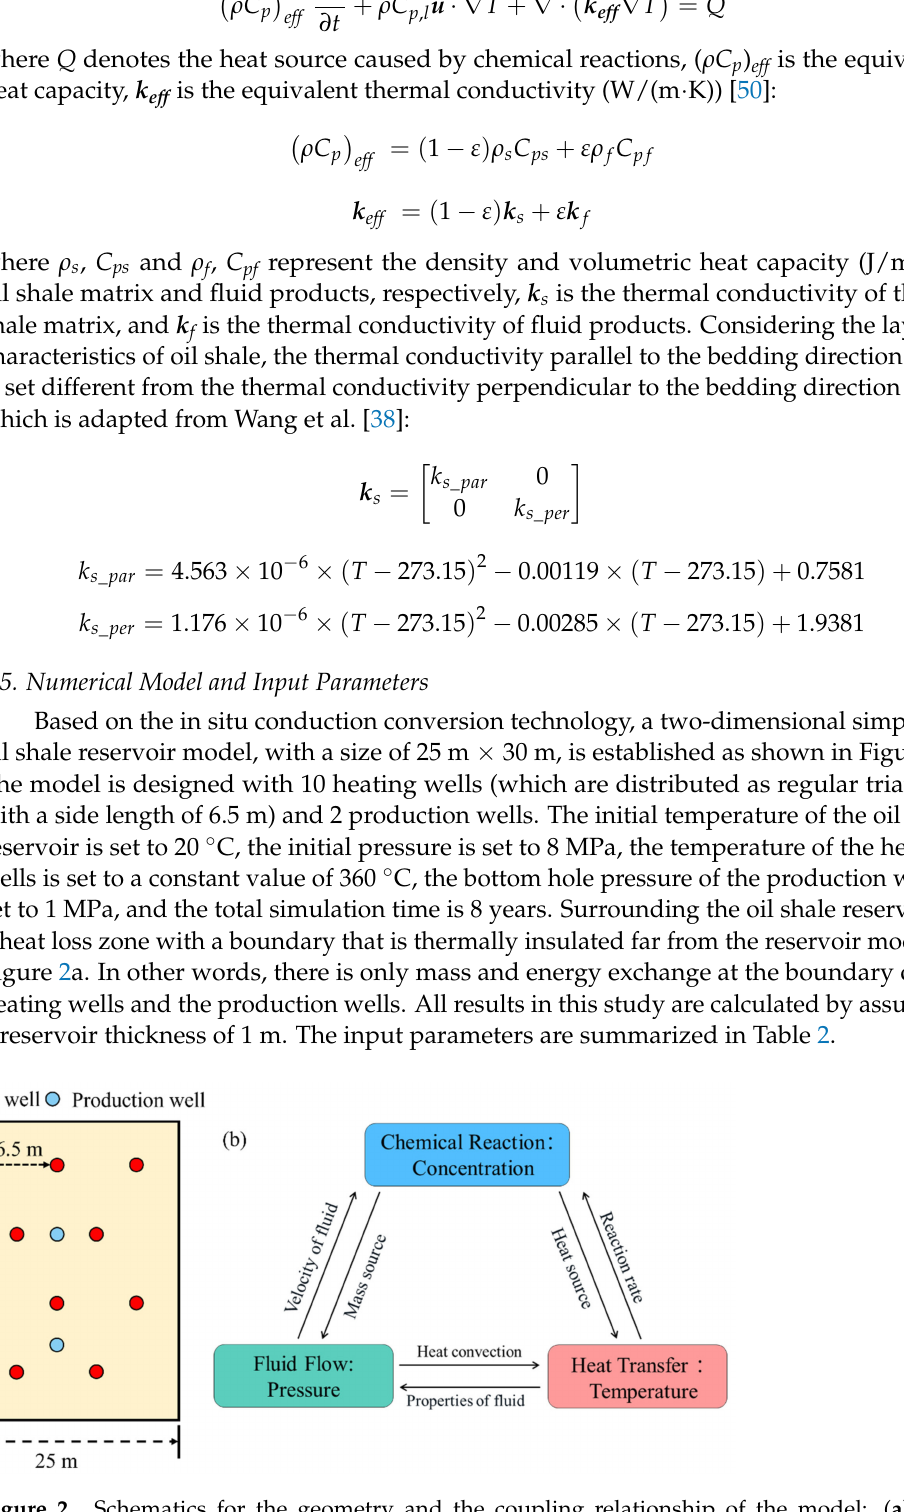
Figure 2. Schematics for the geometry and the coupling relationship of the model: ( a ) two- dimensional oil shale reservoir model; ( b ) the relationship of the coupled physical